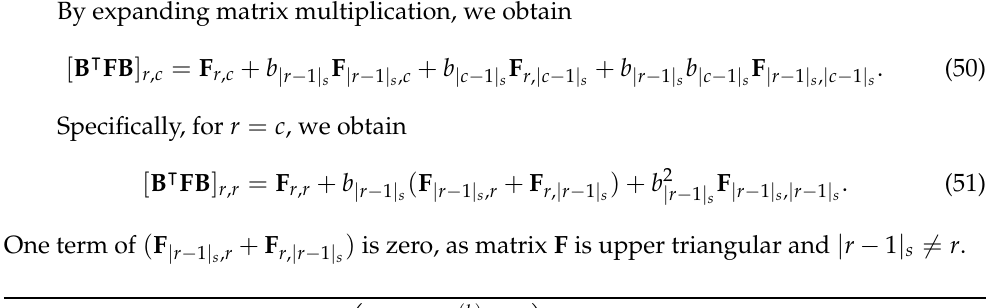
Algorithm 1 Computation of [